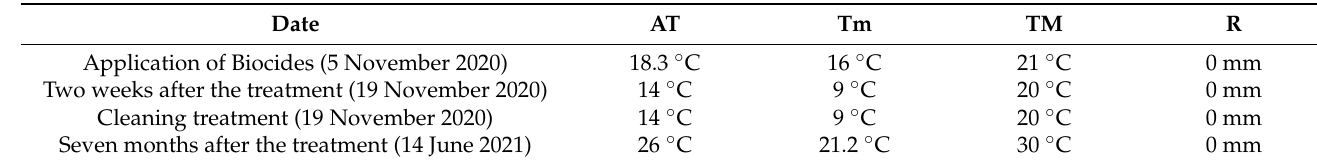
Table 3. Temperature and rainfall data on the specific days of the treatments and analyses. AT = Average Temperature; Tm = minimum Temperature; TM = maximum Temperature; R = maxi- mum